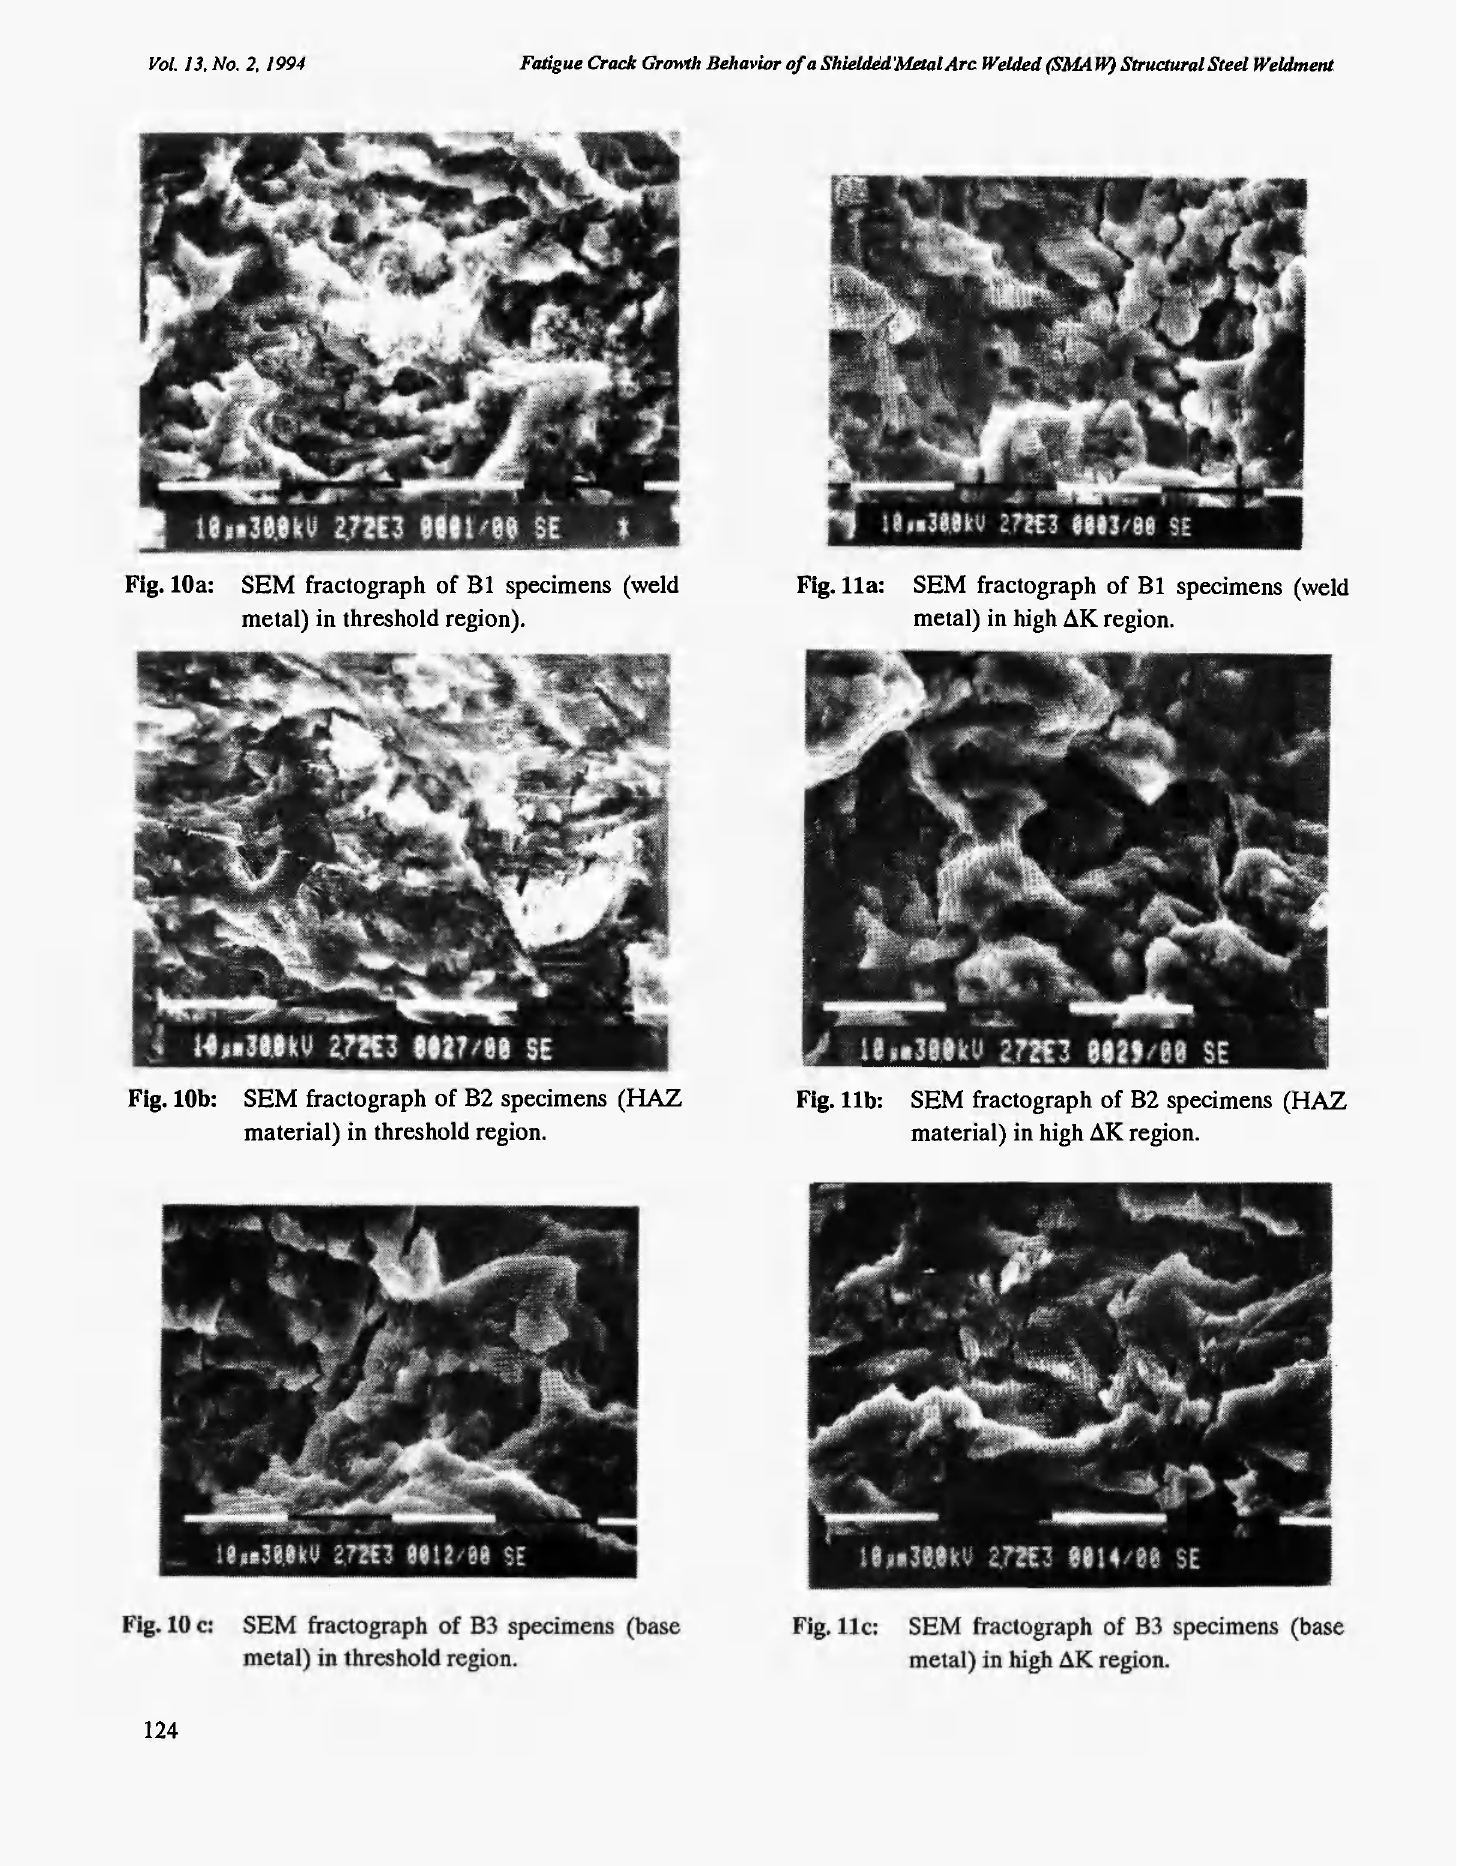
Fig. IIa: SEM fractograph of B1 specimens (weld metal) in high ΔΚ region.